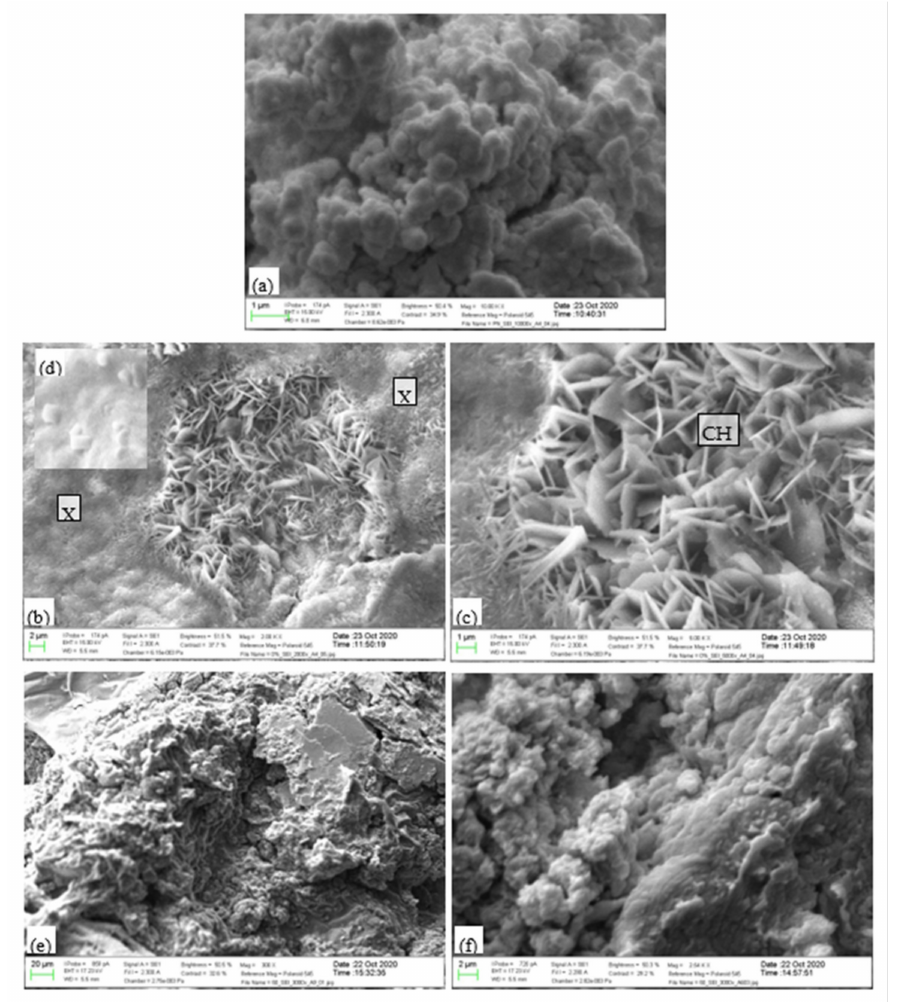
Figure 13. SEM images of ( a ) NSi, ( b – d ) H-0, and ( e , f ) H-50 after exposure to the lime